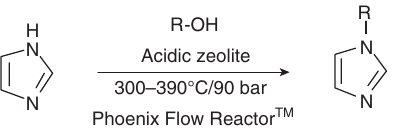
Scheme 1: Typical laboratory synthesis of N -alkyl imidazoles.